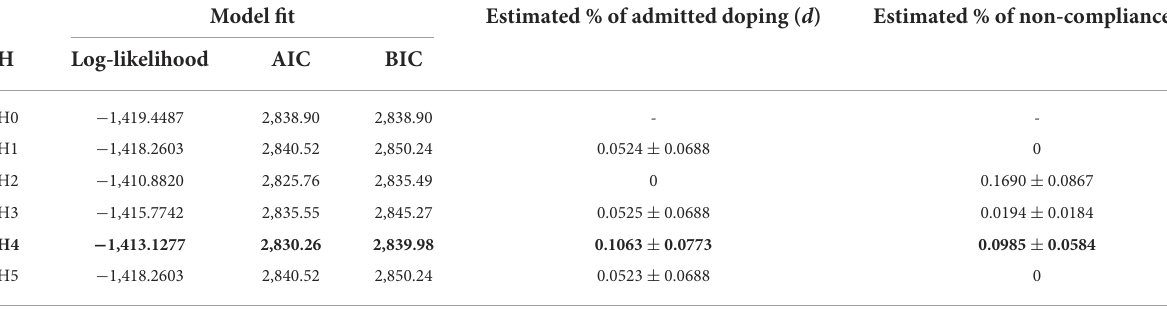
TABLE 6 Estimated use of prohibited performance enhancing substances and/or methods at PAG (12-month prevalence). Model